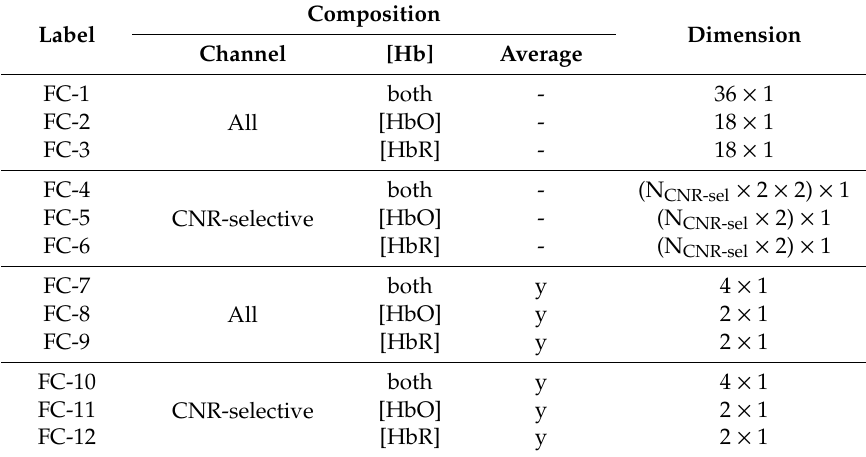
Table 1. The Feature Vector Compositions. For channel, ‘all’ means that all channels were included in a feature vector. ‘CNR-selective’ means only the channels meeting CNR-criteria were included. For [Hb], ‘both’ indicates that both [HbO] and [HbR] were used. If ‘Average’ is ‘y (yes)’, [Hb]s were averaged and the features were calculated from the averaged [Hb]. Note that averaging was done with